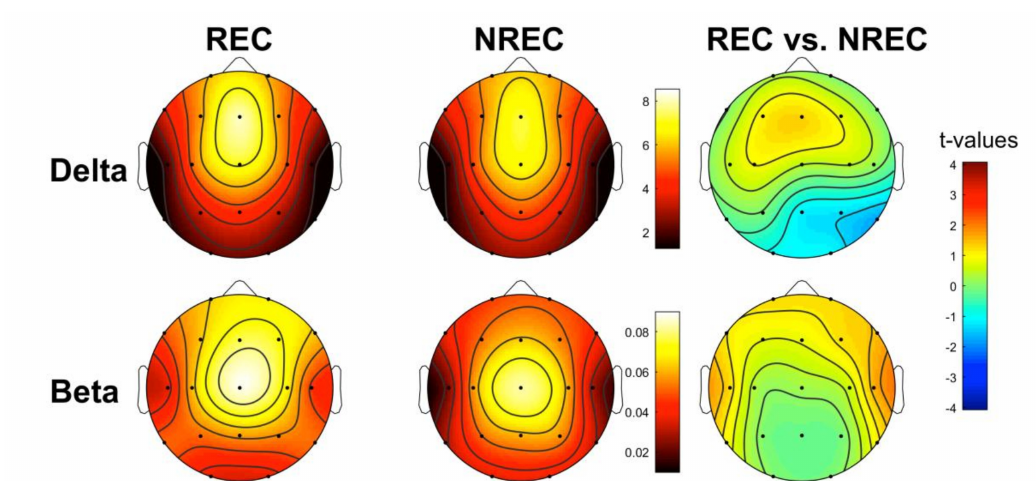
Figure 1. Topographic distribution of the last 5 min of NREM sleep electrophysiological (EEG) power in the non-recall (NREC) and recall (REC) groups and statistical maps. The EEG activity for the delta (0.5–4.75 Hz) and beta (16–24.75 Hz) frequency bands is reported and expressed as the percentage of the total EEG power within the whole topography. The maps are scaled between the minimal and maximal power values for each frequency band, considering both the NREC (1st column) and REC (2nd column) groups. Statistical maps of the comparisons (unpaired t -test) between the NREC and REC groups are also plotted (3rd column) both for the delta and beta band. The statistical maps are scaled symmetrically according to the absolute maximal t -value across the statistical comparisons. No significant di ff erences were found ( p ≤